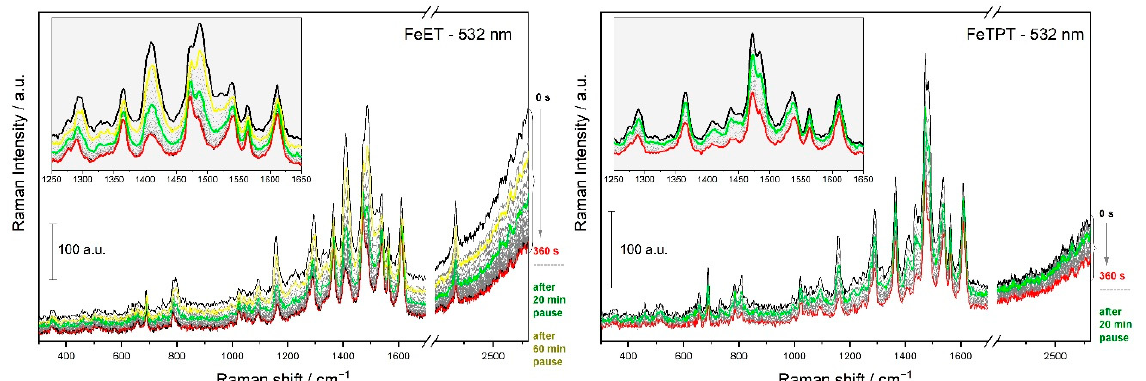
Figure 8. Tests of the reversibility of spectral changes for FeET and TPT . Black—first measured RRS; red—last measured RRS; green—RRS taken after 20 min pause; yellow—RRS taken after 60 min pause. Insets—details of the central parts of RRSs. Laser power 0.1 mW; accumulation time 15 s; total time 6 min.